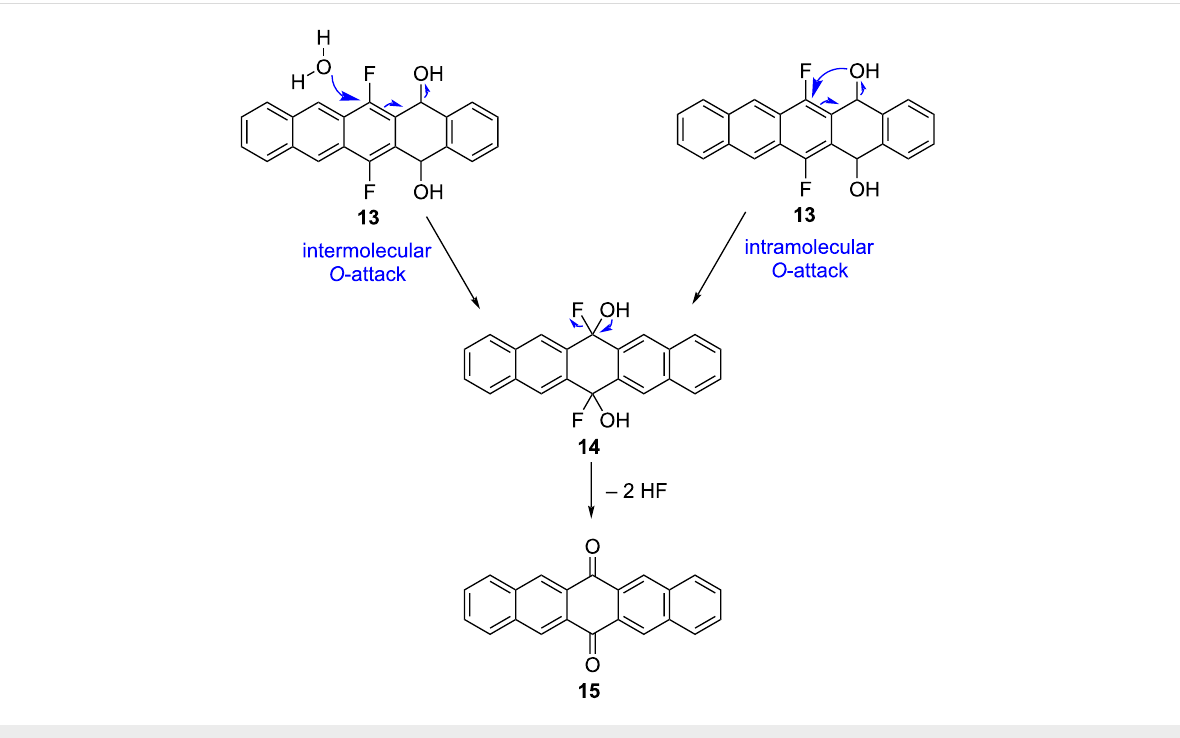
was slow enough to obtain a clean 1 H NMR spectrum (see Supporing Information File 1)